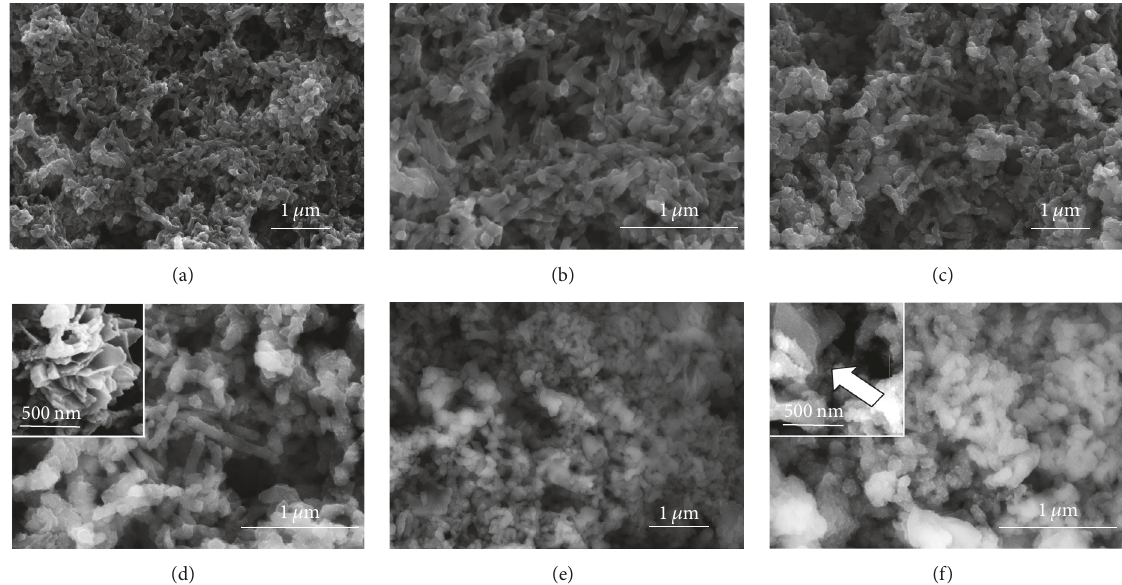
Figure 1: SEM images of PANI layers on metal surface. PANI prepared with simultaneous P1 (a, b) and dropwise P2 (c, d) addition of oxidant. Images (e) and (f) correspond to the dedoped polymer